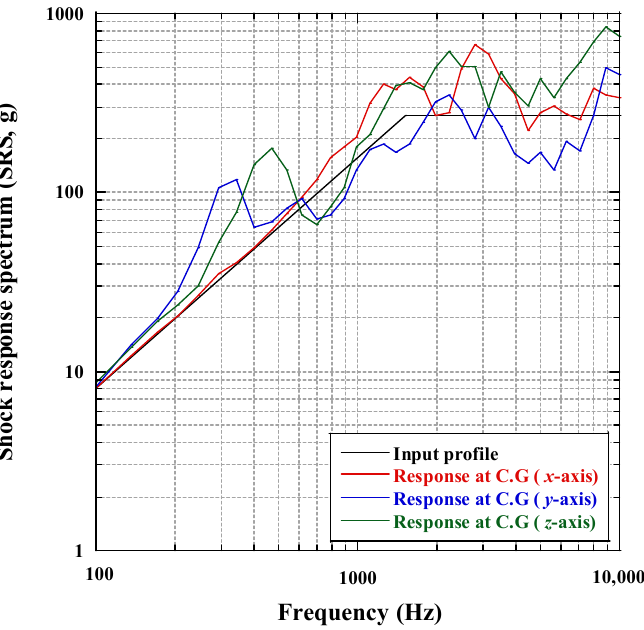
Figure 11. Shock test results of TMCM in each axis. Table 3. Summary of low-level Sine sweep test results for